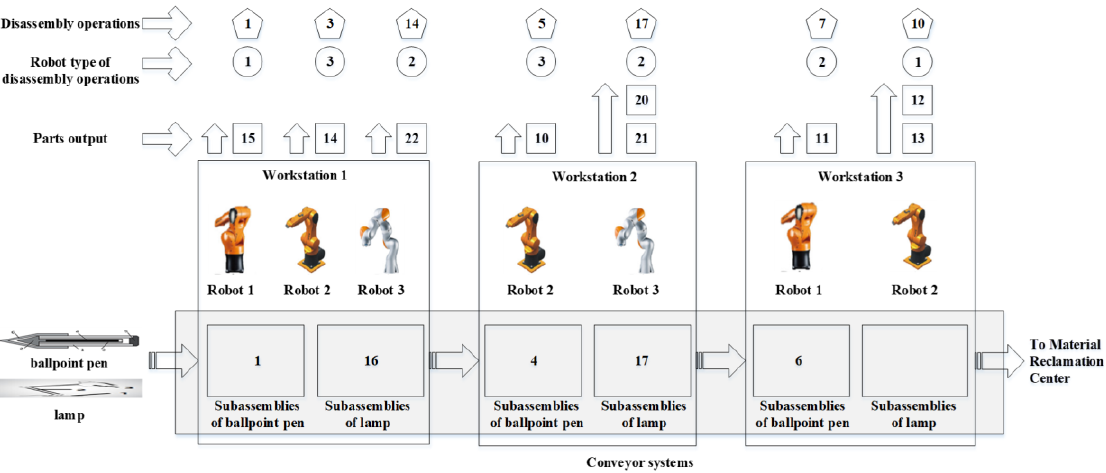
Figure 4. An example of a robotic disassembly line layout.